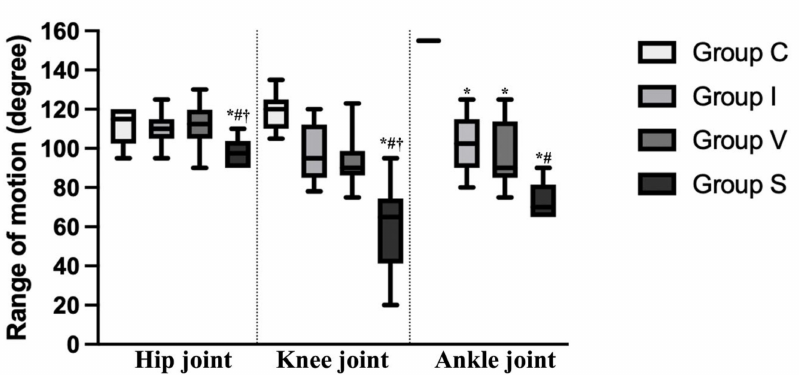
Figure 2. Range of motion of the hip, knee, and ankle joint of the control and immobilization groups on Day 15. The range of motion of each joint was calculated by subtracting the angle of the flexed position from that of the extended position. Data are expressed as median with interquartile ranges. Group C, control group; Group I, cast immobilization group; Group V, Velcro immobilization group; Group S, spiral wire immobilization group. *; Significant difference from Group C within the same joint ( p < 0.05). #; Significant difference from Group I within the same joint ( p < 0.05). †; Significant difference from Group V within the same joint ( p <